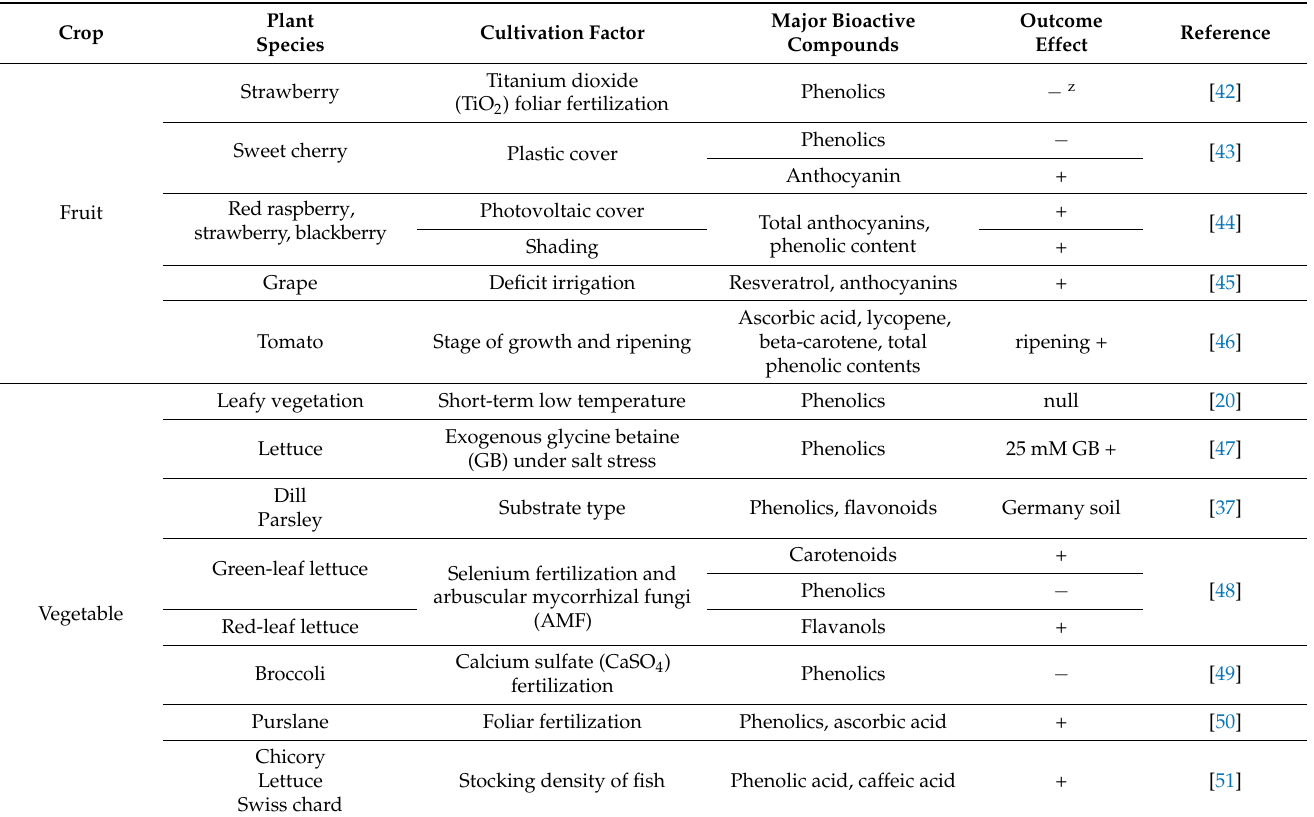
Table 2. Research studies to improve bioactive compound levels in plant foods in ground-based controlled urban